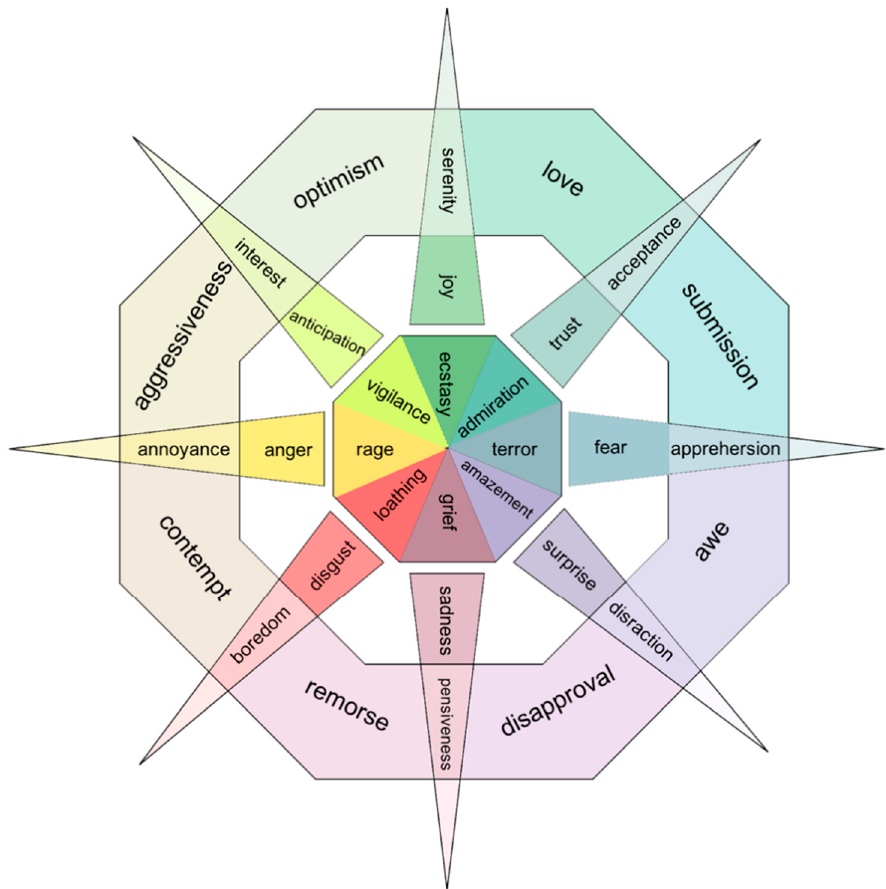
Figure 1. Plutchik’s Wheel of Emotions.